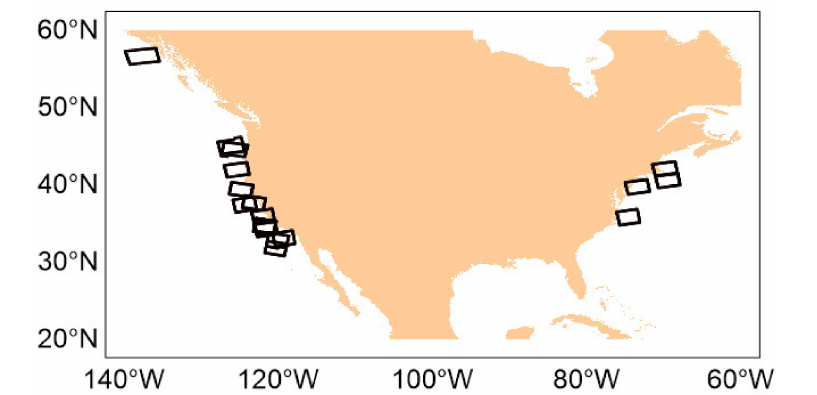
Figure 3. SAR distribution on the east and west coasts of the United